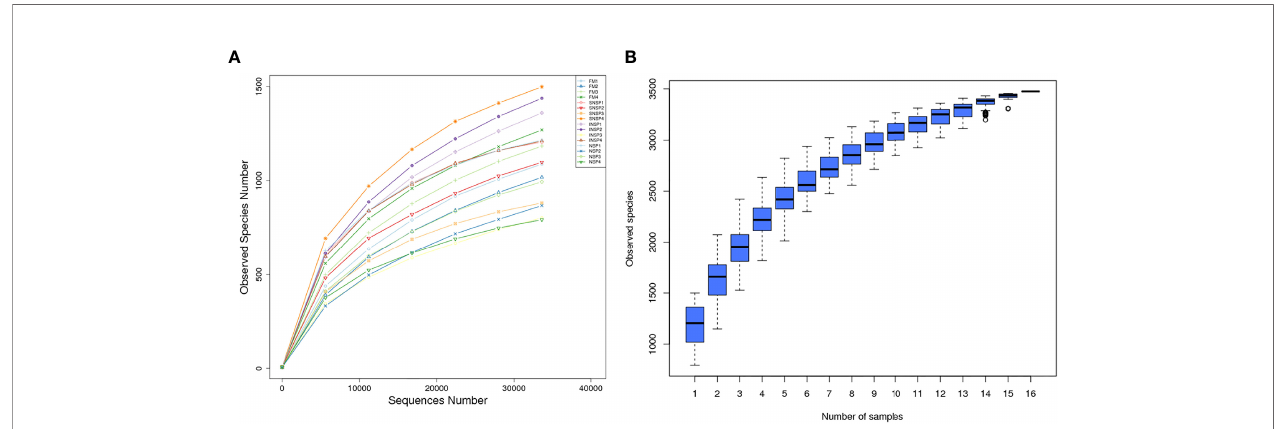
FIGURE 1 | Determine whether the number of tags and samples in this study were suf fi cient for subsequent data analysis. (A) Rarefaction curves were constructed based on the amount of sequencing data extracted in this study and the corresponding number of species. (B) Species accumulation boxplot was used to describe the increasing trend of species diversity as the number of samples